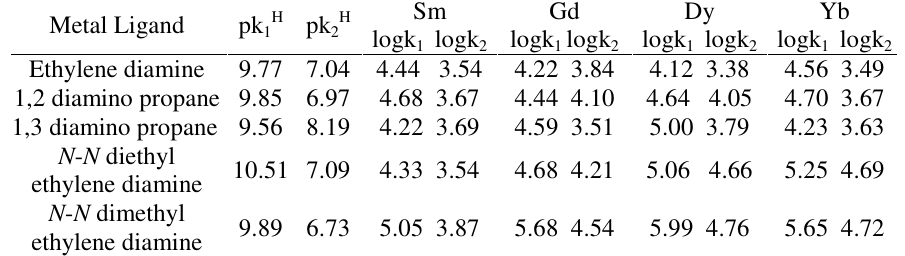
Table 1. Proton-ligand and metal–ligand stability constants of lanthanone(III) ions